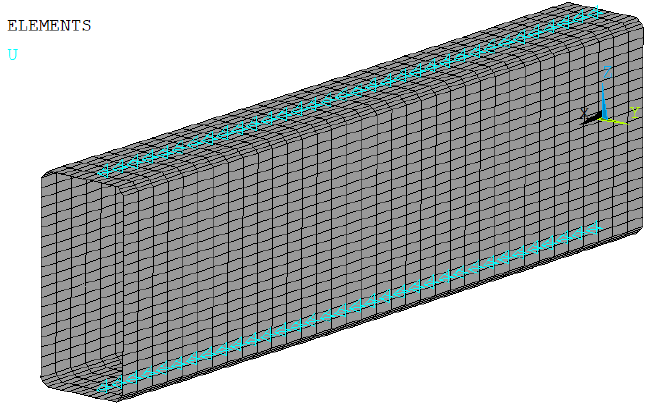
Figure 32. Lateral restraints of beam-columns with RHS cross-section.